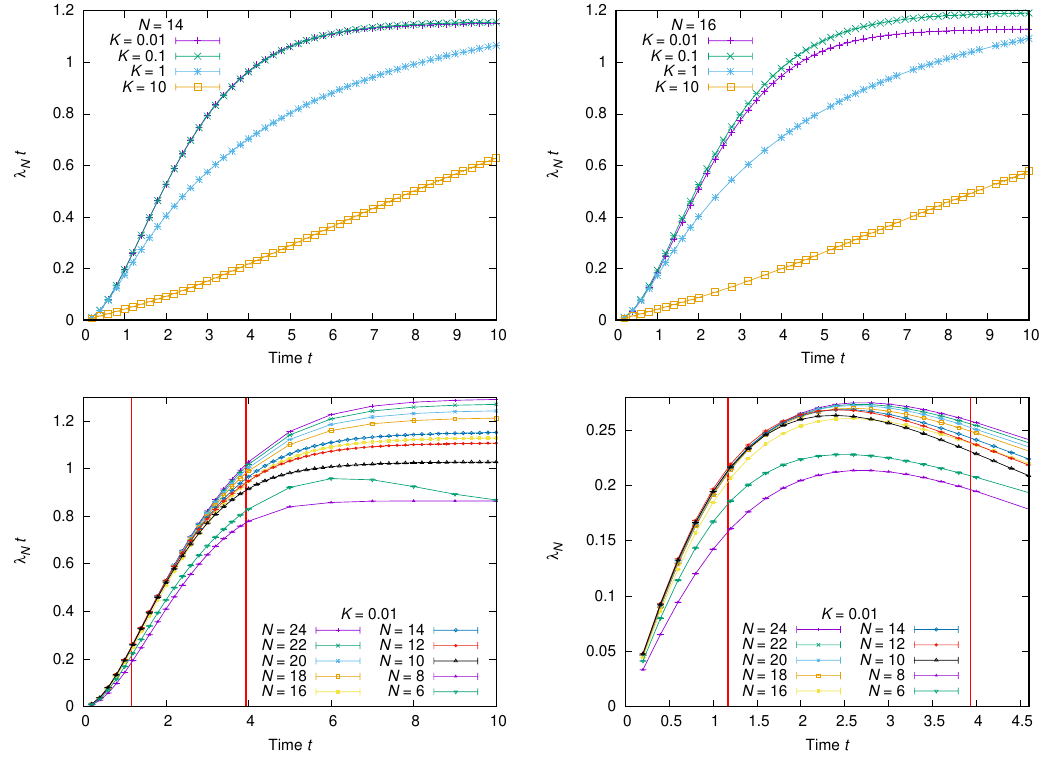
Figure 7 . The average of the largest Lyapunov exponents obtained using all eigenvectors of the generalized SYK model. [Upper-left] (cid:21) N t vs t for N = 14, various K . [Upper-right] (cid:21) N t vs t for N = 16, various K . [Lower-left] The N dependence of (cid:21) N t for K = 0 : 01. The vertical lines corresponding to 20% and 80% of the plateau value (at t = 10) of (cid:21) L t for N = 20 are also shown. [Lower-Right] The N dependence of (cid:21) N for K = 0 : 01.